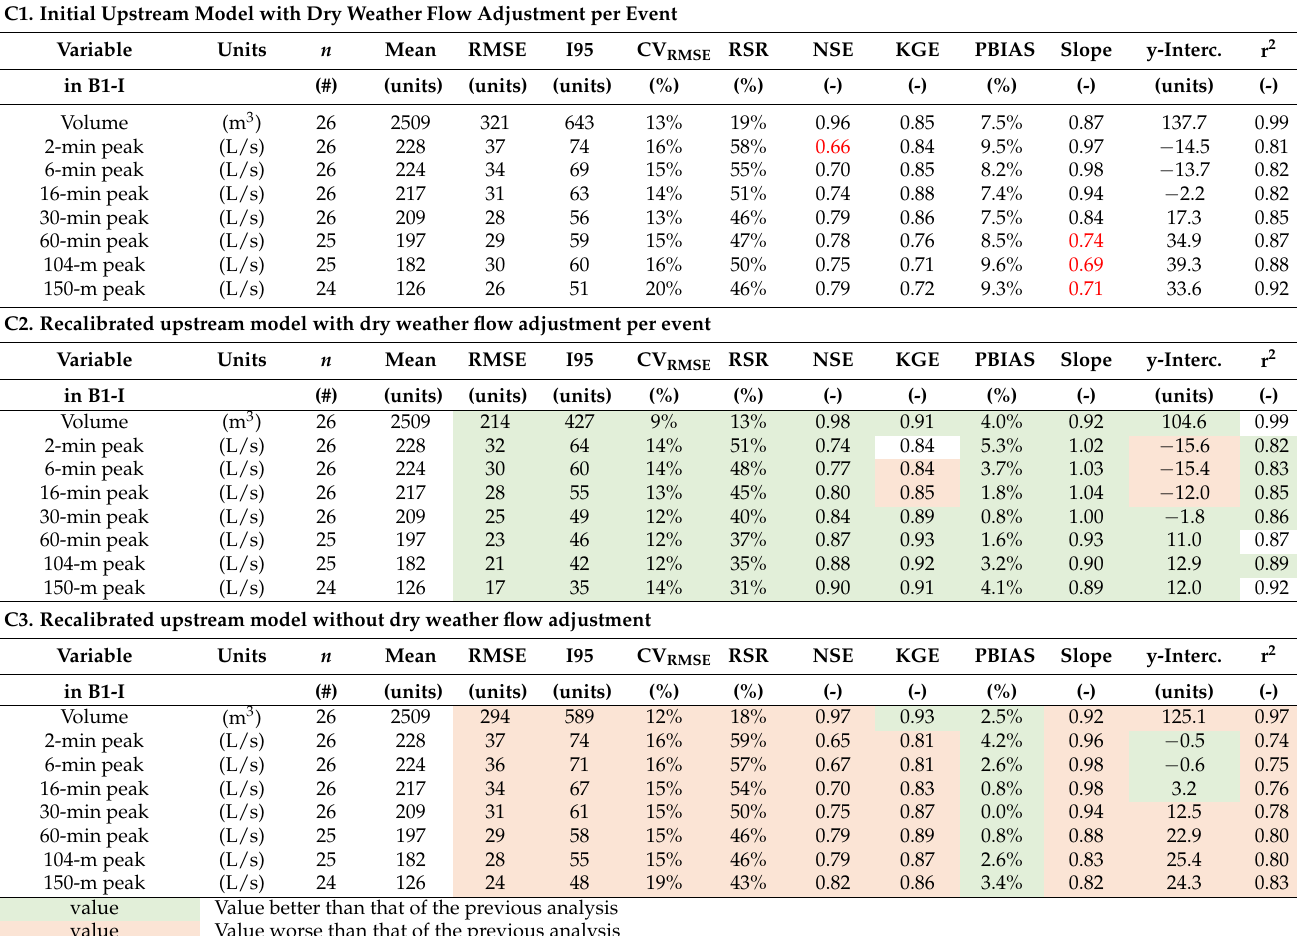
Table 4. Statistical results in the upstream monitoring section